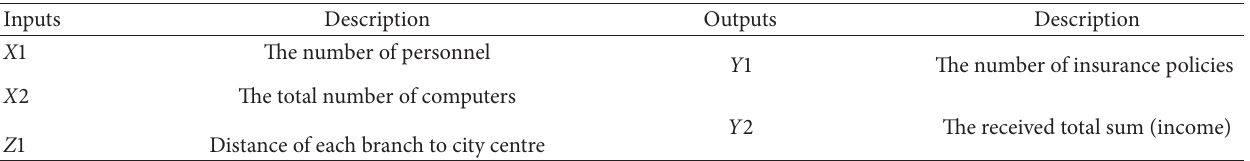
Table 2: Labels of inputs and outputs.